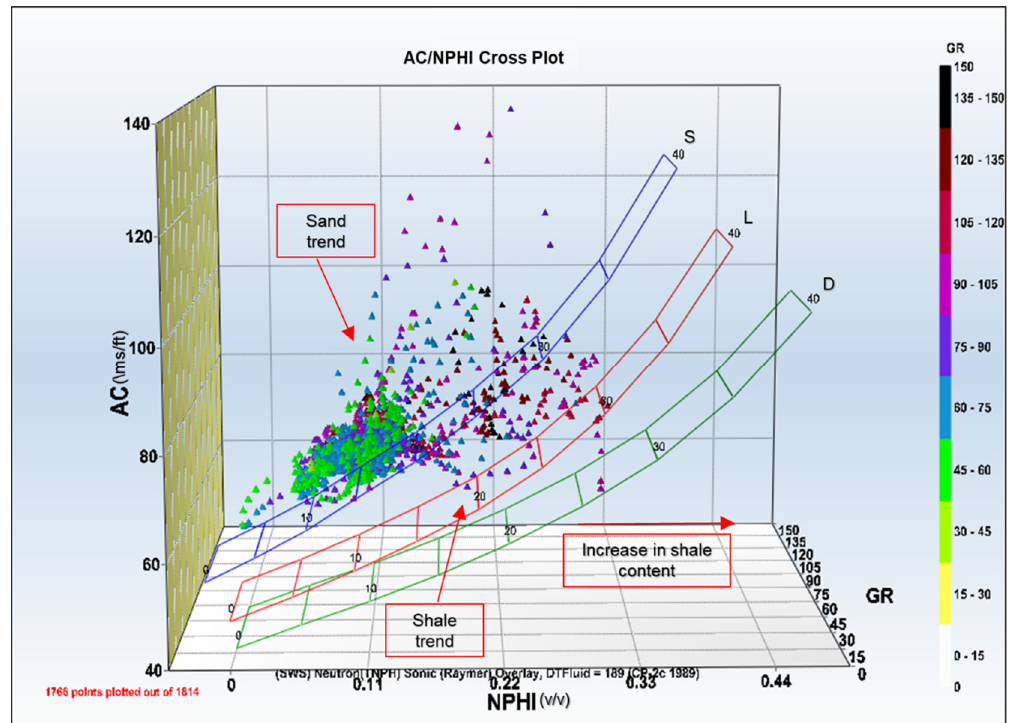
Figure 6. Density (RHOB)/neutron (NPHI) cross plot for multi-well analysis with discriminator gamma-ray response.